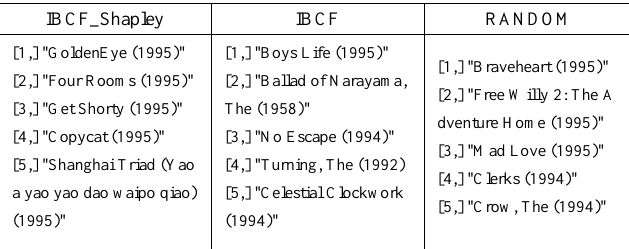
Table 5. Five movies in MovieLense are consulted on three models